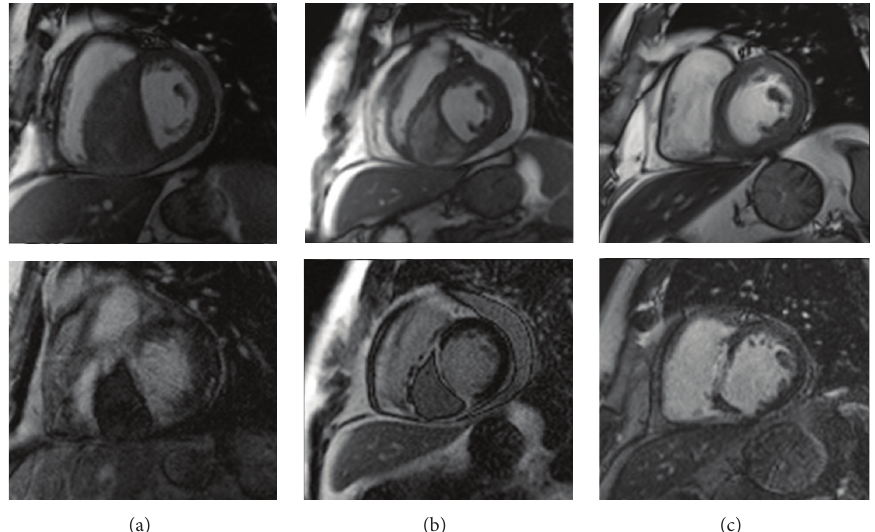
Figure6:Follow-upCMRafteronemonth(b)and6months(c)revealedanearlycompleteresolutionofthehematoma,toprow:end-diastolic phase of a 4D cine-SSFP sequence of a basal slice in a short axis view, bottom row: corresponding late gadolinium enhancement images. LGE imaging revealed a transmural LGE with a central intramural hypointensity, corresponding to an intramural haematoma extending from the septal to the inferior wall, from the base to the